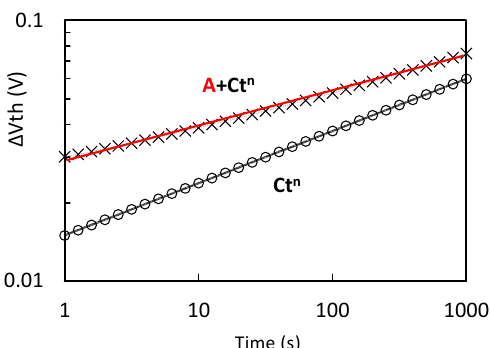
Figure 20. When a constant, A, was added to the power law, the data (symbol ‘×’) could still be fitted with the power law reasonably well, but the power exponent (i.e., the slope of the red line) was underestimated, when compared with its real value (i.e., the slope of the black line). As AHTs are located below Ev, they can be readily discharged. This explains why NBTI